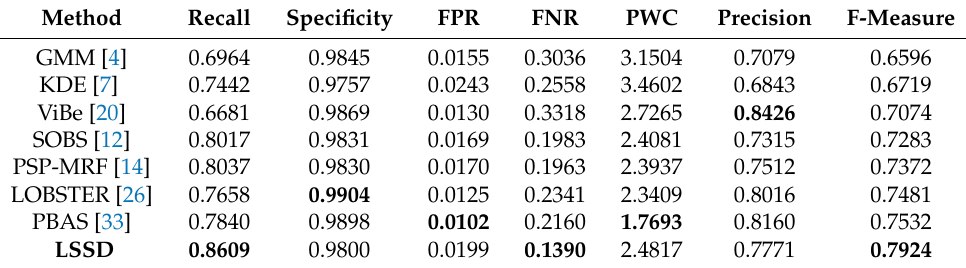
Table 4. Comparison of the results on the CDnet2012 dataset by different methods.